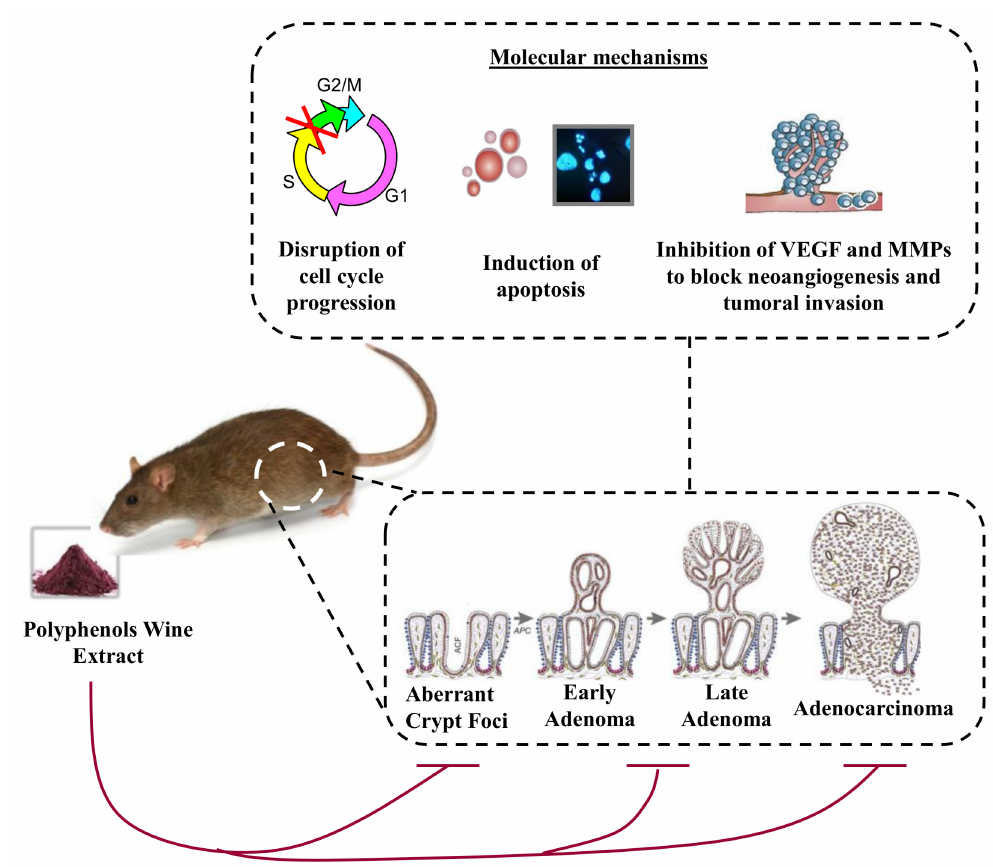
Figure 2. Wine polyphenol extract is able to prevent aberrant crypt foci formation in various animal models (mice, rats), which is the first step of colorectal carcinogenesis, and can block the different steps leading to adenocarcinoma development. The effects involved different molecular mechanisms such as an arrest of the cell cycle in the S phase, an induction of apoptosis through caspase activation, and an inhibition of angiogenesis and tumoral invasion through a decrease in vascular endothelial growth factor (VEGF) secretion and matrix metalloproteinases (MMP)